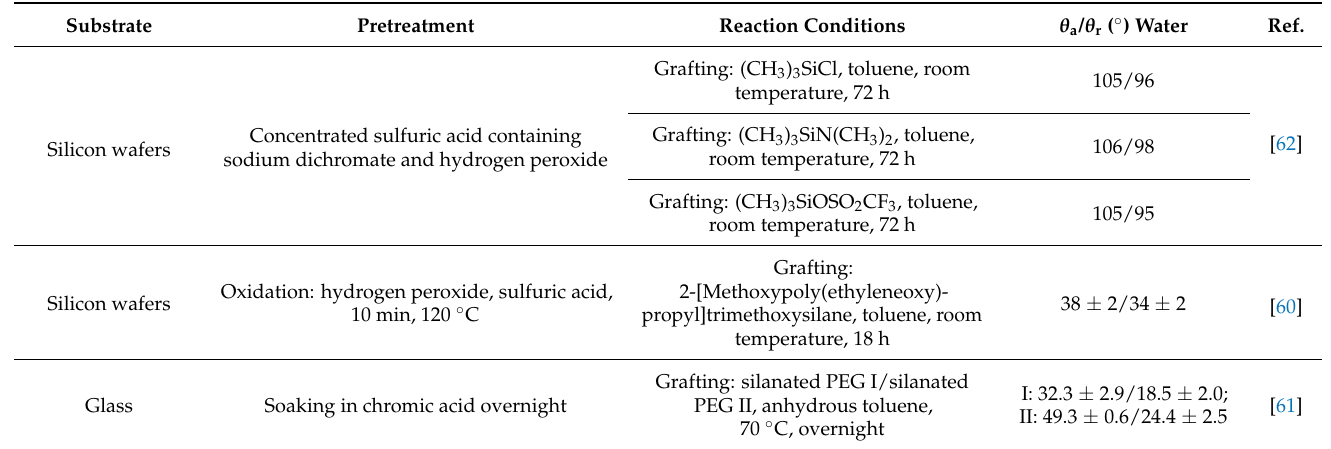
Table 1. Surface modification methods reported in the